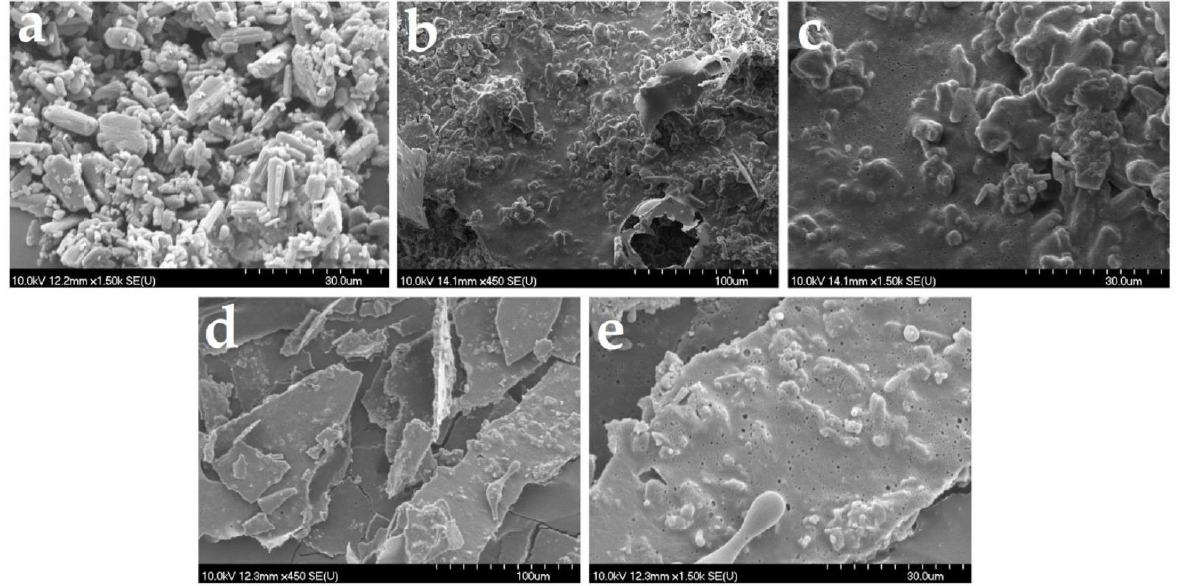
Figure 9. SEM images of raw loratadine ( a ) and OL formulations L1_10 mg_0.5 mL with 100 µm ( b ), 30 µm ( c ) magnitude, and L13_10 mg_0.5 mL with 100 µm ( d ), 30 µm ( e ) magnitude. 30 µ m ( c ) magnitude, and L13_10 mg_0.5 mL with 100 µ m ( d ), 30 µ m ( e )